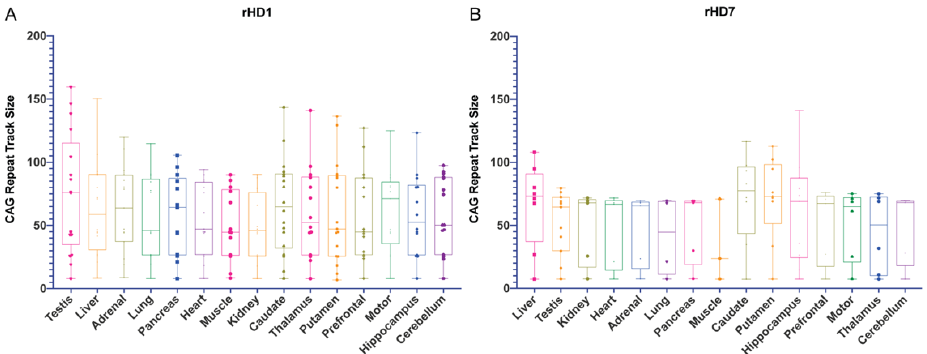
Figure 2. Curve-fit data of rHD1 and rHD7 arranged from the tissues with the highest CAG expansion to most stable. ( A ) Testis showed the largest CAG expansion and showed the emergence of multiple large alleles derived from 77Q. The kidney showed little emergence of larger alleles among peripheral tissue samples. Among the central nervous tissue samples, caudate, thalamus, and putamen showed similar emergency of larger alleles derived from 77Q. ( B ) Liver showed the largest CAG expansion followed by the testis in rHD7 among the peripheral tissue samples. Other peripheral tissue samples showed relatively stable CAG size while the muscle was the most stable. The caudate, hippocampus, and putamen showed a large CAG expansion among the central nervous samples, while the other samples were stable.